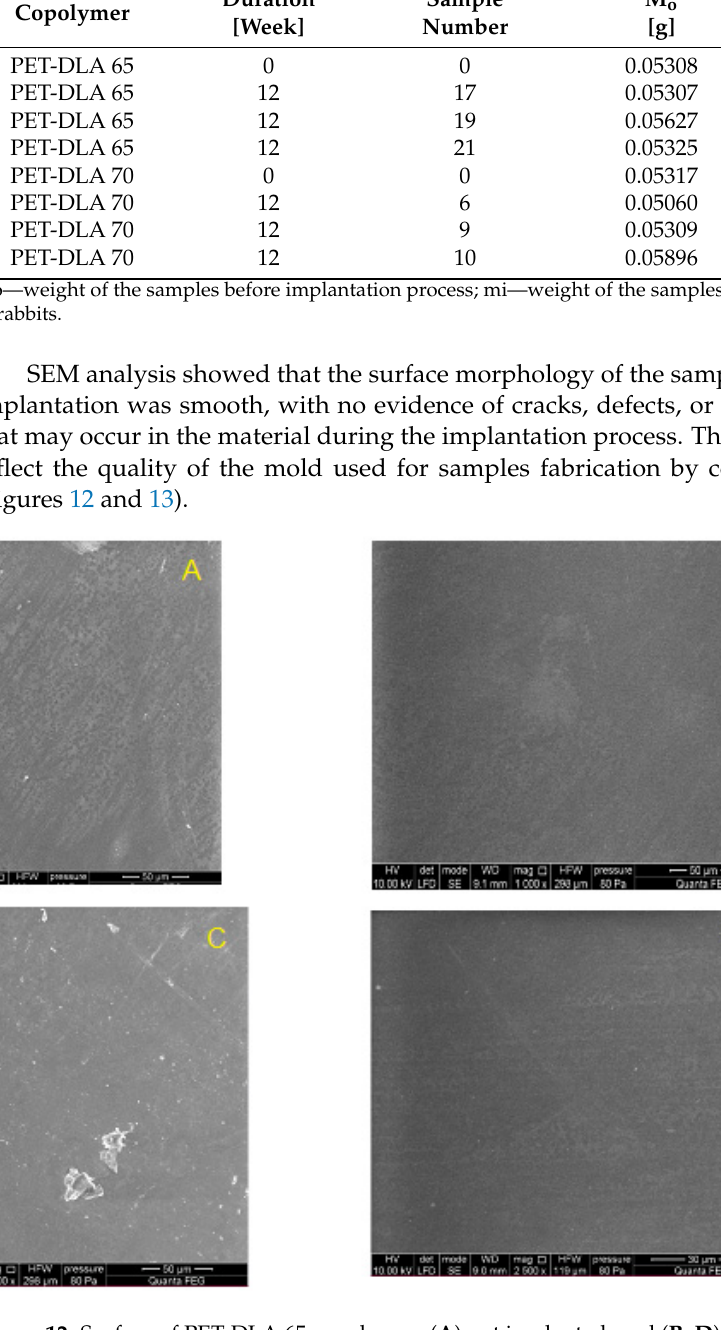
Figure 12. Surface of PET-DLA 65 copolymer: ( A ) not implanted, and ( B , C , D ) after 12-week implan- tation period.